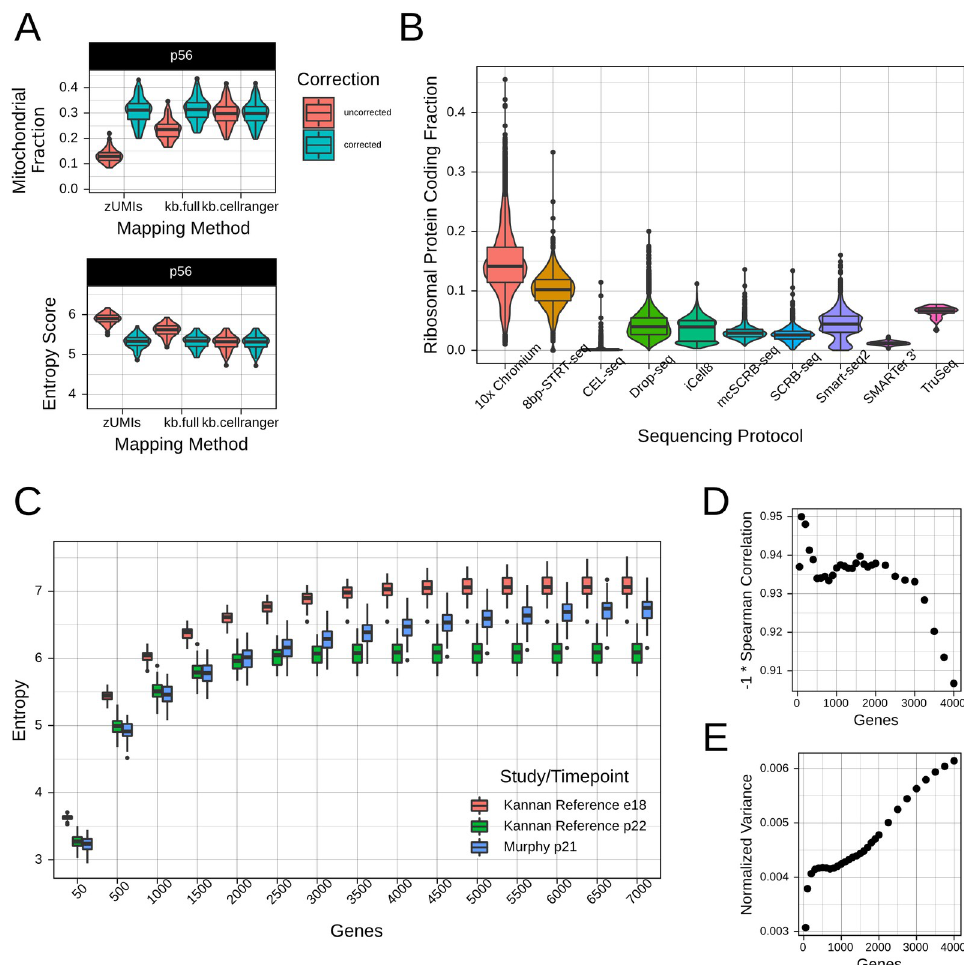
Fig 2. Gene filtration facilitates cross-study comparisons of entropy. A . Correction of mismapped mitochondrial reads. The use of a genomic mapping algorithm (such as zUMIs) or a “full” reference containing pseudogenes can lead to erroneous mapping of mitochondrial genes to pseudogenes, in turn inflating entropy score. We included a correction step that facilitates usage of data from a range of mapping pipelines. B. Proportion of ribosomal protein coding genes in mouse in vivo datasets, grouped by library preparation method. Given the clear protocol-dependence of these genes, we eliminated them from analysis. C. Entropy at different gene subsamplings for two studies with different sensitivities. Data from e18 and p22 from the maturation reference and p21 from Murphy et al. are shown. D. Spearman correlation between entropy and timepoint for different gene subsamplings (using median of entropy for each timepoint and study). E. Normalized variance of entropy for different gene subsamplings (using median of entropy for each timepoint). We normalized by scaling entropy at every subsampling to [0, 1].